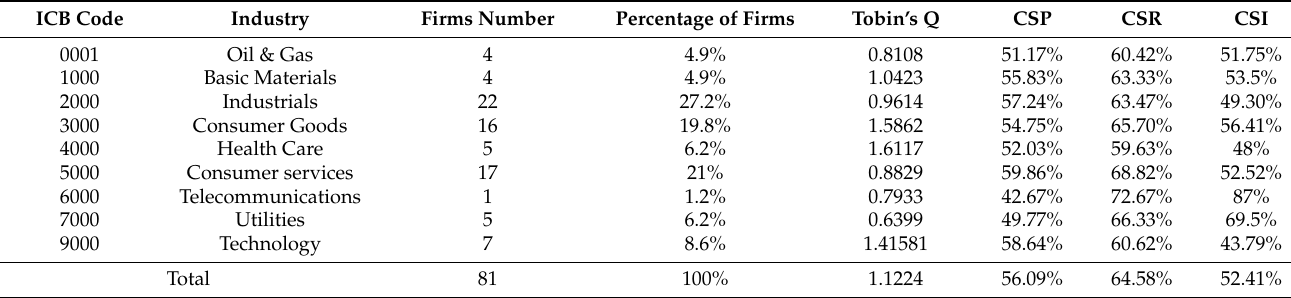
Table 2. Descriptive statistics by